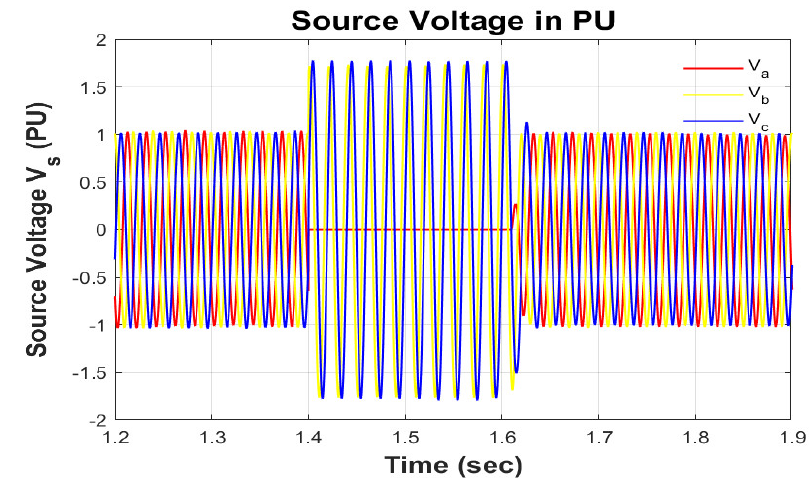
Figure 20. Behaviour of source voltage during L − G fault.